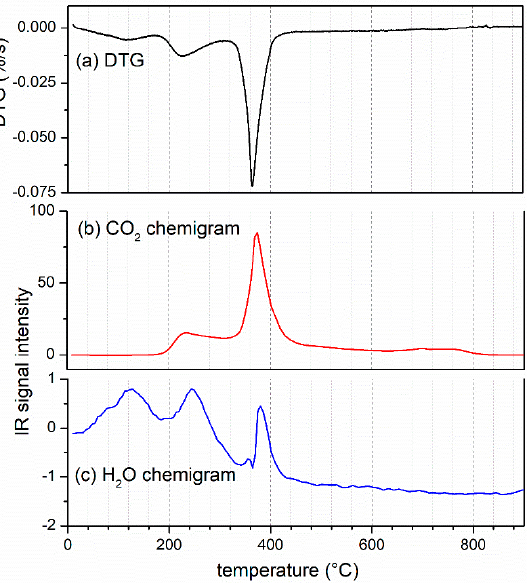
Figure 5. TGA − FTIR results of the N − C sample under N 2 at the heating rate of 5 °C/min: ( a ) DTG Figure 5. TGA–FTIR results of the N–C sample under N 2 at the heating rate of 5 ◦ C/min: ( a ) DTG curve, ( b ) CO 2 evolution profile, and ( c ) H 2 O evolution profile. curve, ( b ) CO 2 evolution profile, and ( c ) H 2 O evolution profile.